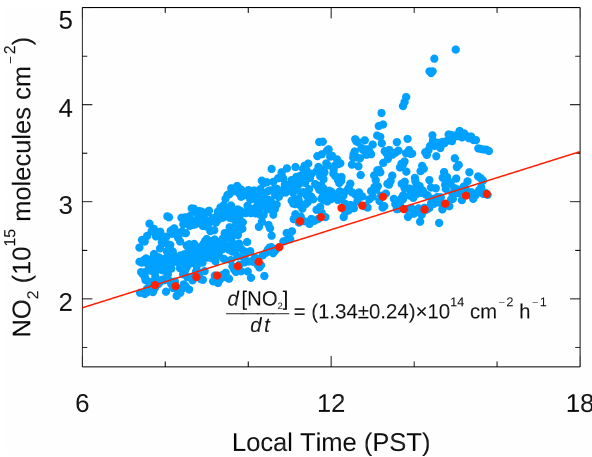
Figure 7. The daytime NO 2 increase obtained from the baseline of the observed diurnal variability. The blue points are the same as the daytime data shown in Fig. 4. The red points are the 10th percentile of the daytime data in 30min intervals between 07:00 and 16:00PST, which form a baseline of the daytime